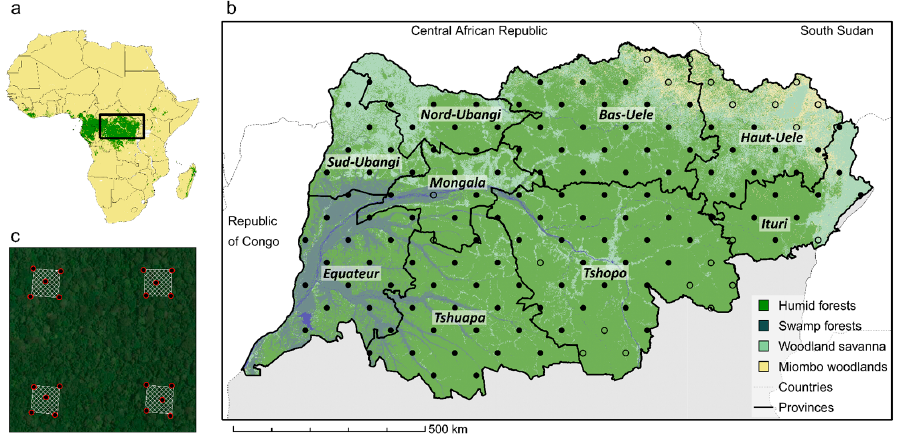
Figure 1. ( a ) Location of the study area (black rectangle) in Africa. ( b ) Spatial distribution of sampling units within the study area. Sampling units that were effectively sampled are represented with filled black circles, while sampling units left unsampled are represented with empty black circles. Thick and thin black lines represent countries and DRC provinces borders, respectively. Land cover classes from [18] are represented over the study area, while the rest of DRC is colored in light gray. ( c ) Illustrative example of one sampling unit with plots as white hashed squares and GPS measurement locations as red circles. Satellite image background comes from Google